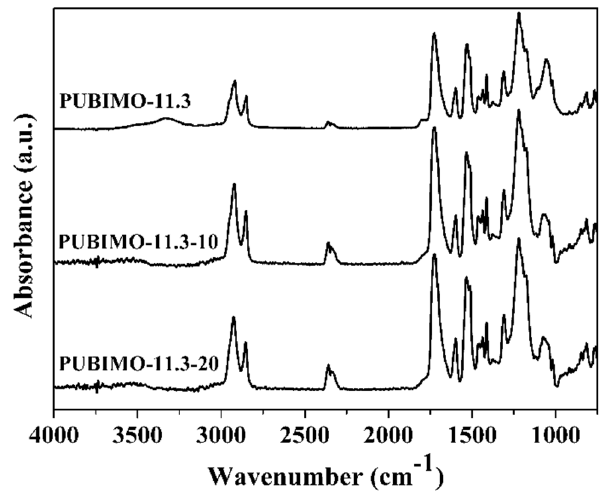
Figure 3. FTIR spectra of PUBIMO-11.3, PUBIMO-11.3-10, and PUBIMO-11.3-20.